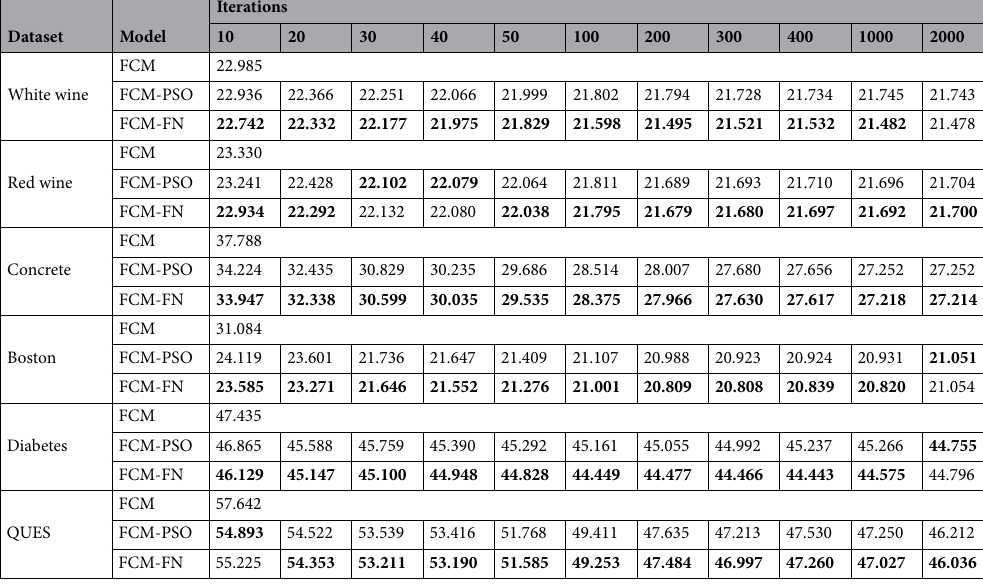
Table 7. The SMAPE of the three models after different iterations’ optimization (%). Significant values are in [bold].